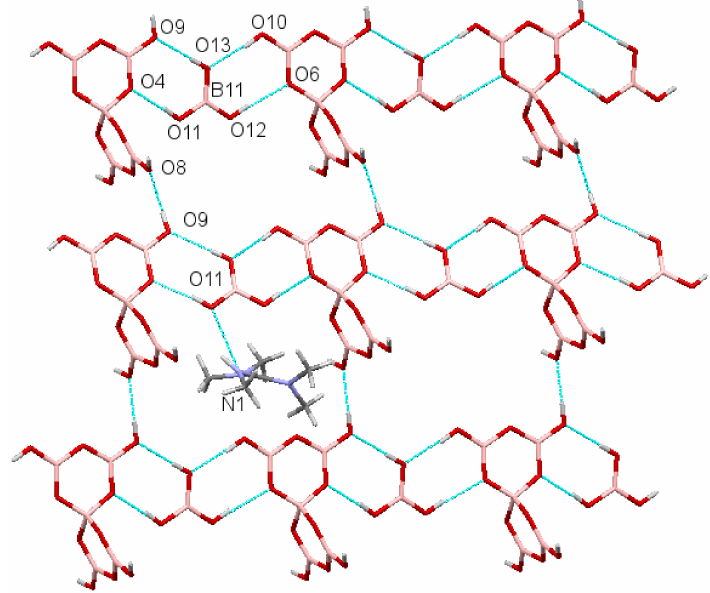
Figure 4. In [C(NHMe)(NMe 2 ) 2 ][B 5 O 6 (OH) 4 ] · B(OH) 3 ( 5 ) the “horizontal” chains (three partially shown) of alternating H-bonded R 22 (8) pentaborate(1-)/boric acid units are cross-linked by H-bonded C(8) “vertical” chains (O9H9 · · · O8 (cid:48) ) into planes. For clarity, H atoms are not labelled but are num- bered the same as the oxygen/nitrogen atom to which they are attached. The [C(NHMe)(NMe 2 ) 2 ] + cations (one shown) fill the “voids” and are H-bonded to the B(OH) 3 units (N1H1 · · ·